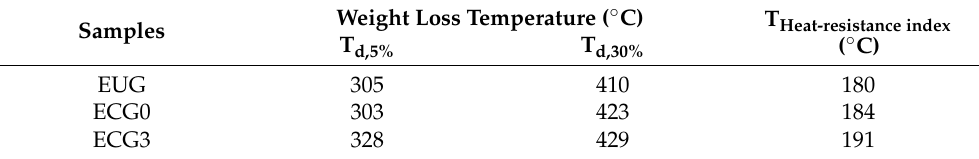
T 5 and T 30 correspond to the decomposition temperature of 5% and 30% weight loss, respectively.;